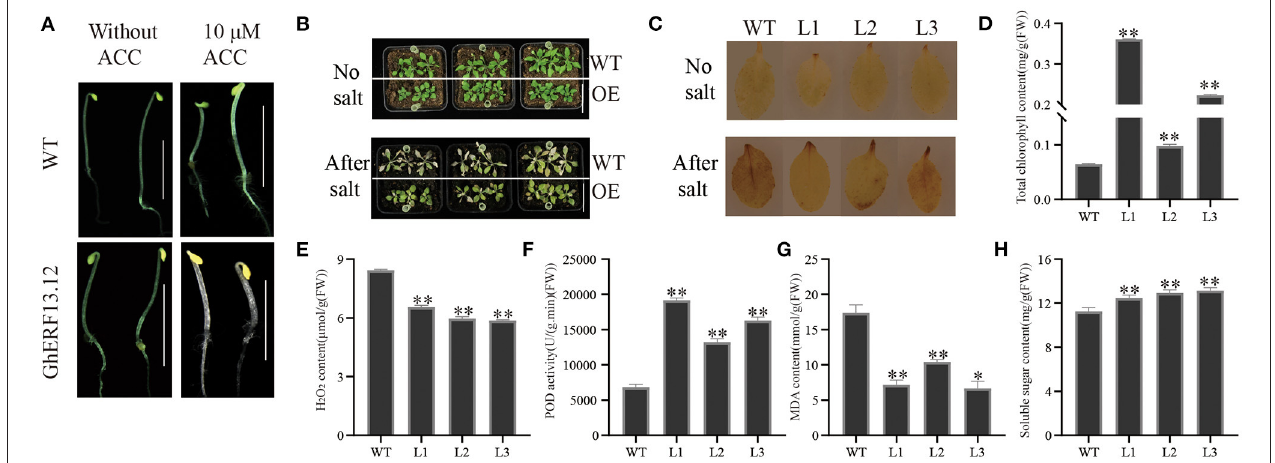
FIGURE 5 | Ectopic expression of the GhERF13.12 gene in Arabidopsis and salt stress treatment. (A) Comparison of hypocotyl length in GhERF13.12 overexpressing lines and WT plants with and without ACC treatment. (B) Salt stress treatment of GhERF13.12 overexpressing lines and WT plants. Bar = 3cm. (C) DAB staining of GhERF13.12 overexpressing lines and WT plants with and without salt treatment. Physiological analysis, such as (D) total chlorophyll amount, (E) H 2 O 2 content, (F) POD activity, (G) MDA content, and (H) soluble sugar content in WT and GhERF13.12 overexpressing lines in Arabidopsis. The standard deviation among three biological replicates is shown by the error bars. * p < 0.05 and ** p < 0.01 (Student’s t -test). WT, wild type; L1, L2, and L3, GhERF13.12 transgenic homozygous